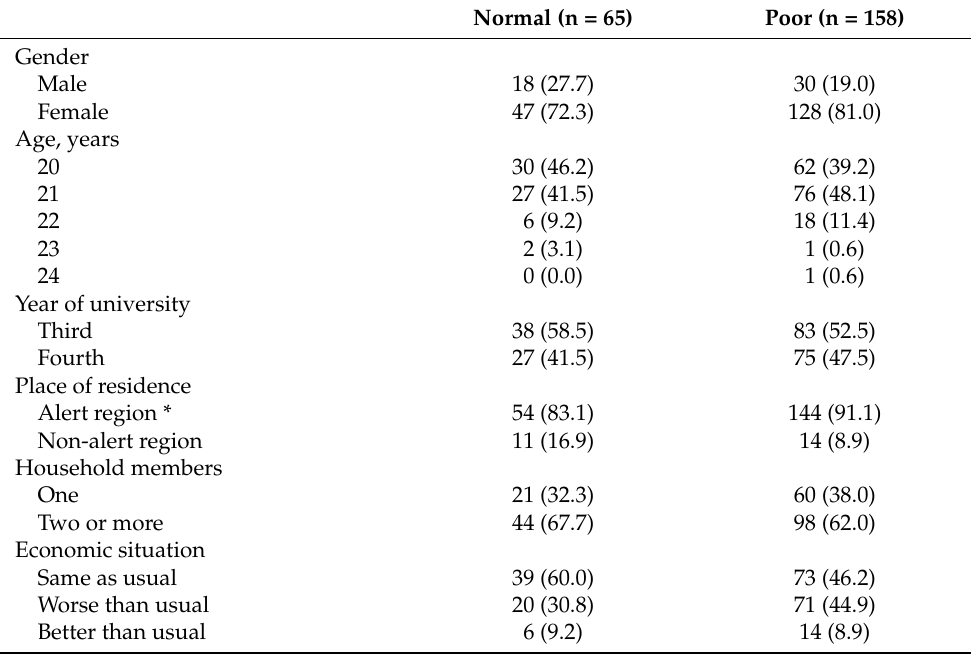
Table 3. Demographic characteristics of students with normal and poor mental health